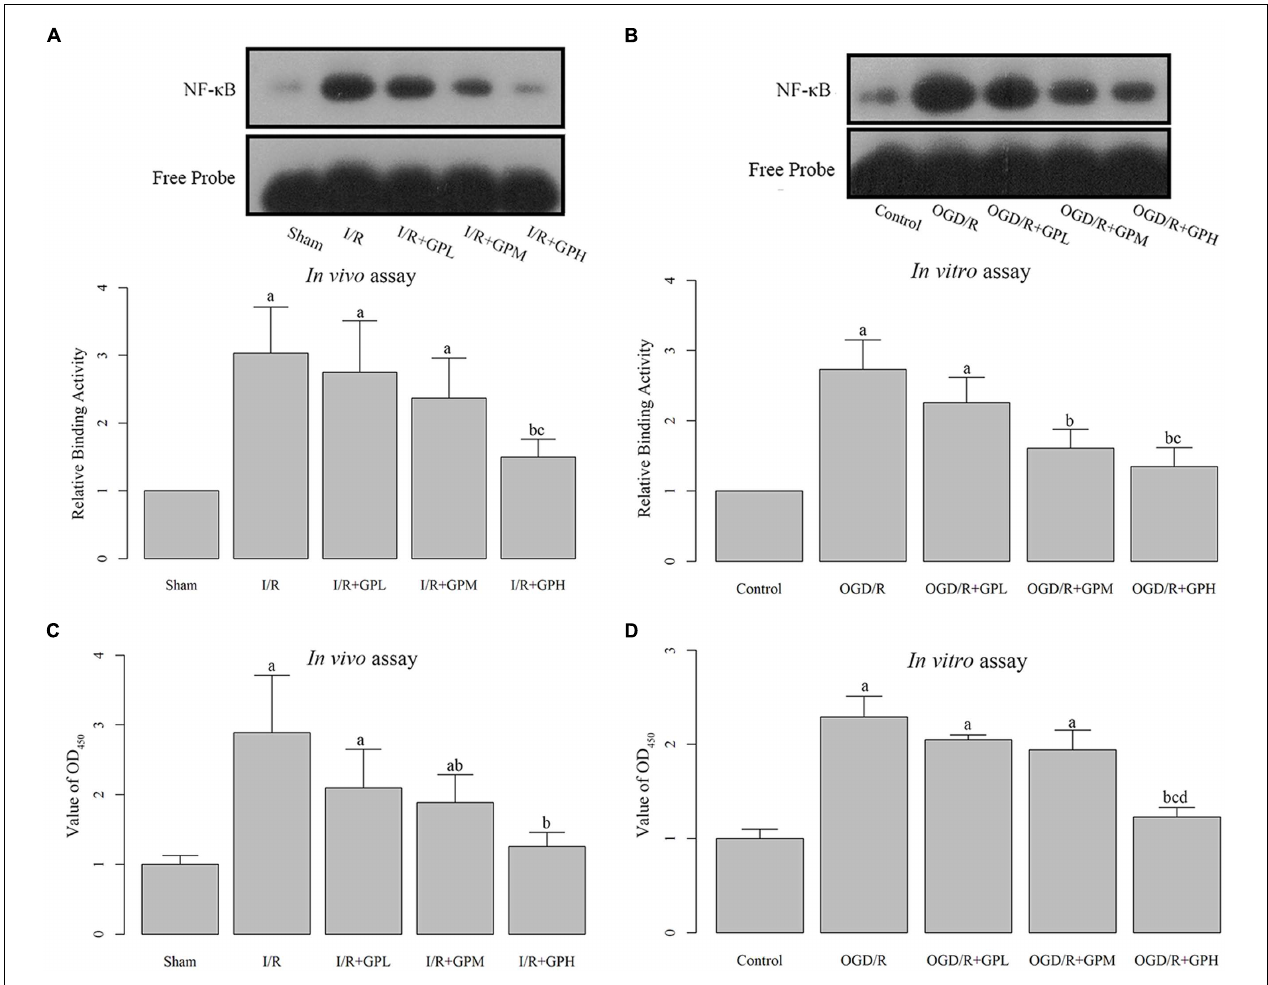
FIGURE 3 | Treatment with GP significantly inhibited the production and nuclear translocation of NF- κ B. (A) The graph represented the relative NF- κ B binding activity, and the image represented the EMSA results in I/R injured rats. (B) The graph represented the relative NF- κ B binding activity, and the image represented the EMSA results in OGD/R H9c2 cells. (C) The NF- κ B activity was analyzed using a NF- κ B p65 ELISA Kit, and value of OD 450 represented the activity of NF- κ B p65 in I/R injured rats. (D) The NF- κ B activity was analyzed using a NF- κ B p65 ELISA Kit, and value of OD 450 represented the activity of NF- κ B p65 in OGD/R H9c2 cells. a, significantly different from sham or Control group, P < 0.05. b, significantly different from I/R or OGD/R group, P < 0.05. c, significantly different from sham group I/R + GPL or OGD/R + GPL group, P < 0.05. d, significantly different from OGD/R + GPM group, P <